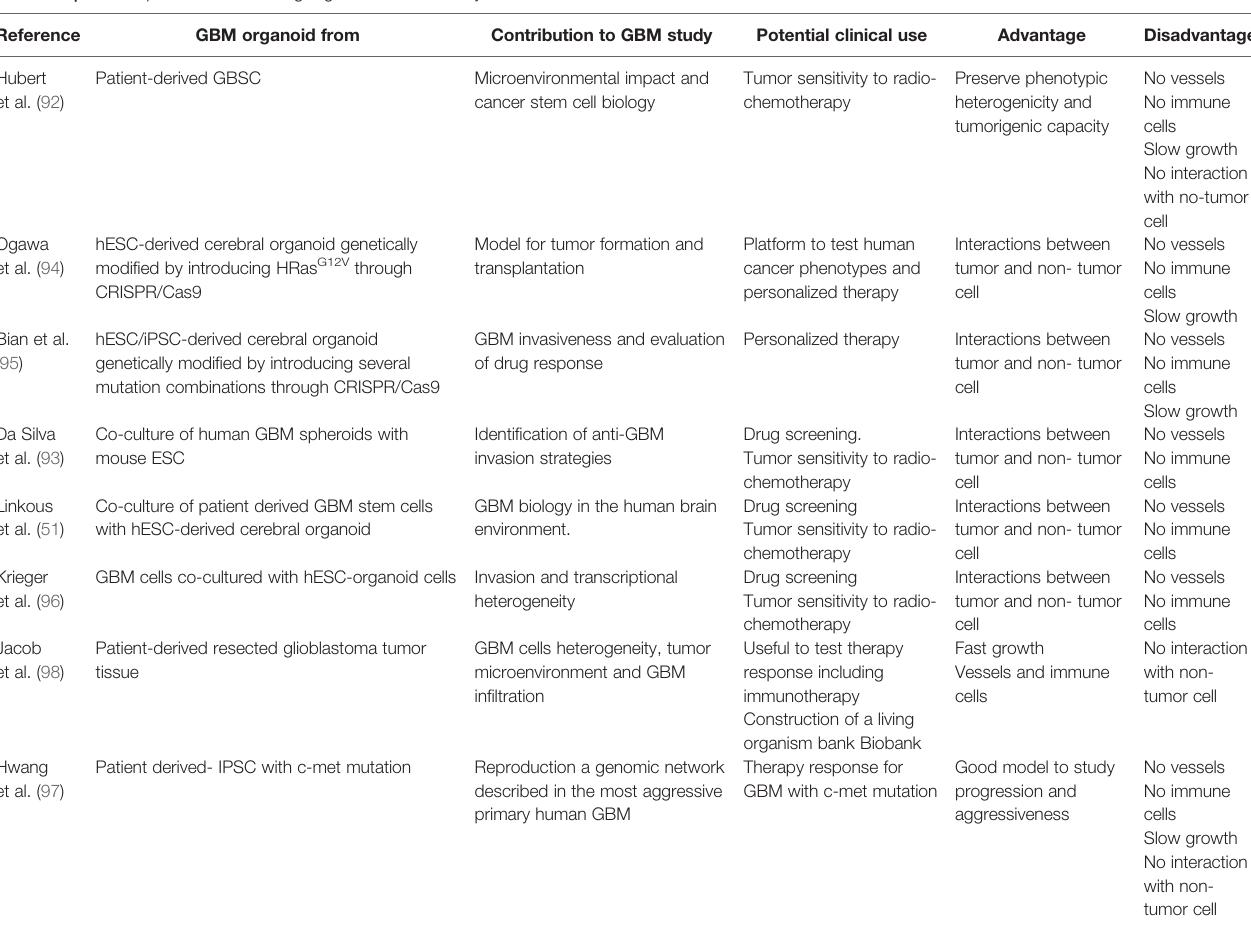
TABLE 3 | Current preclinical trials using organoids for the study of